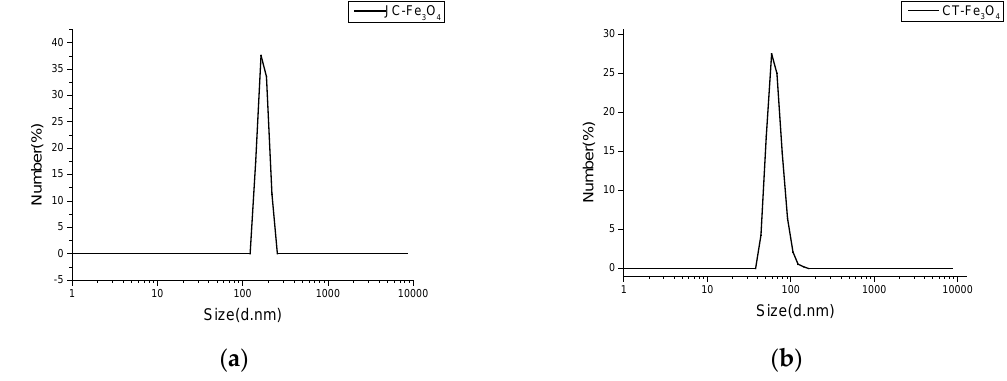
Figure 1. DLS curve of ( a ) JC-Fe 3 O 4 nanoparticle; ( b ) CT-Fe 3 O 4 nanoparticle.